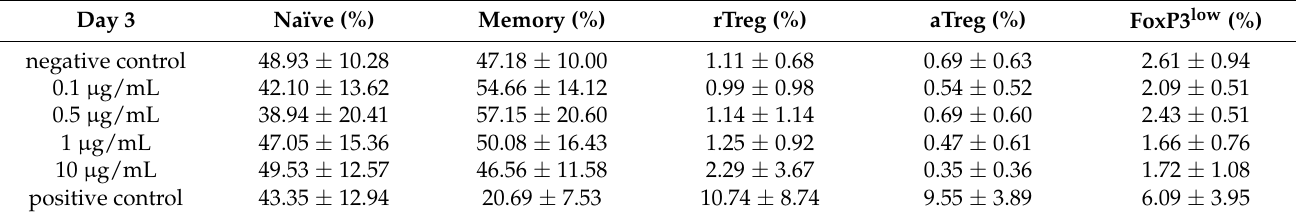
Table 4. Variation in CD4 + subpopulations after incubation with ZnO-NP in different concentrations for 72 h. There were no significant differences between treated cells and the negative control. Data represent the mean +/ − standard deviation (n =